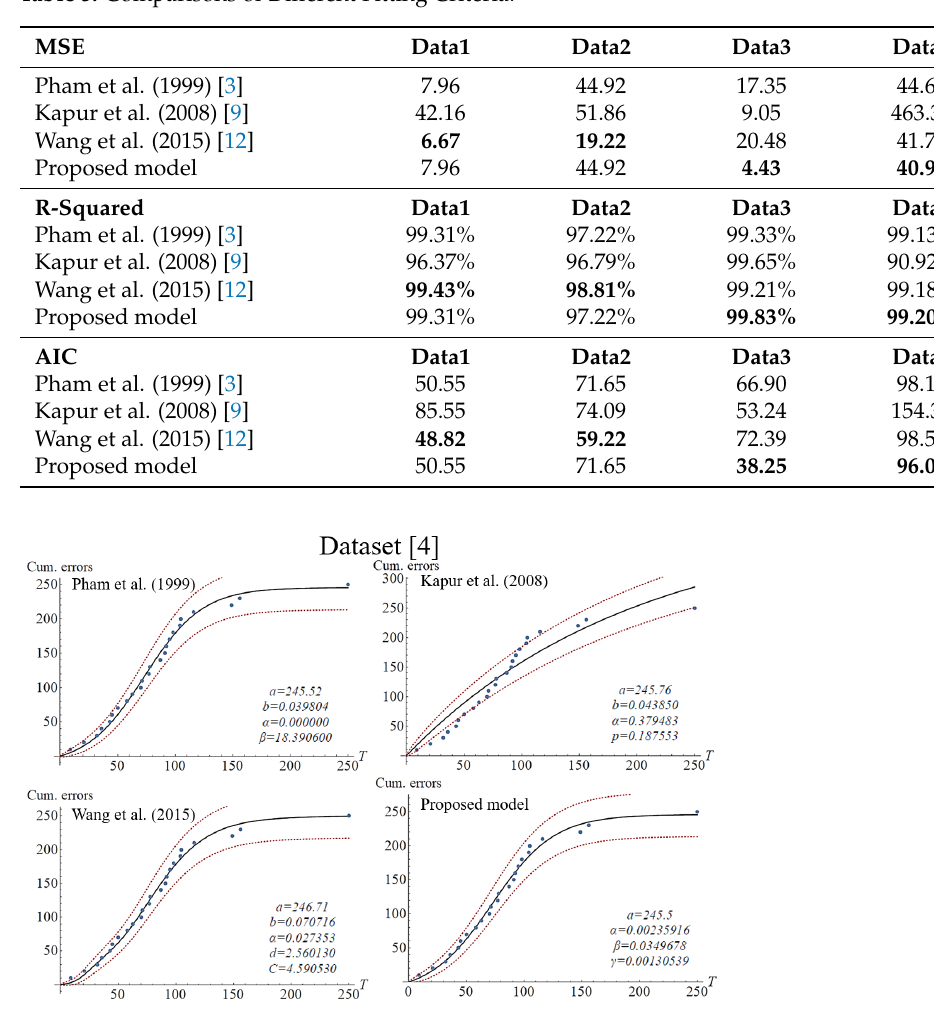
Figure 5. Goodness-of-Fit and Estimated Values of Models’ Parameters, and 95% Confidence Intervals for Dataset (4). Table 5. Comparisons of Different Fitting Criteria.